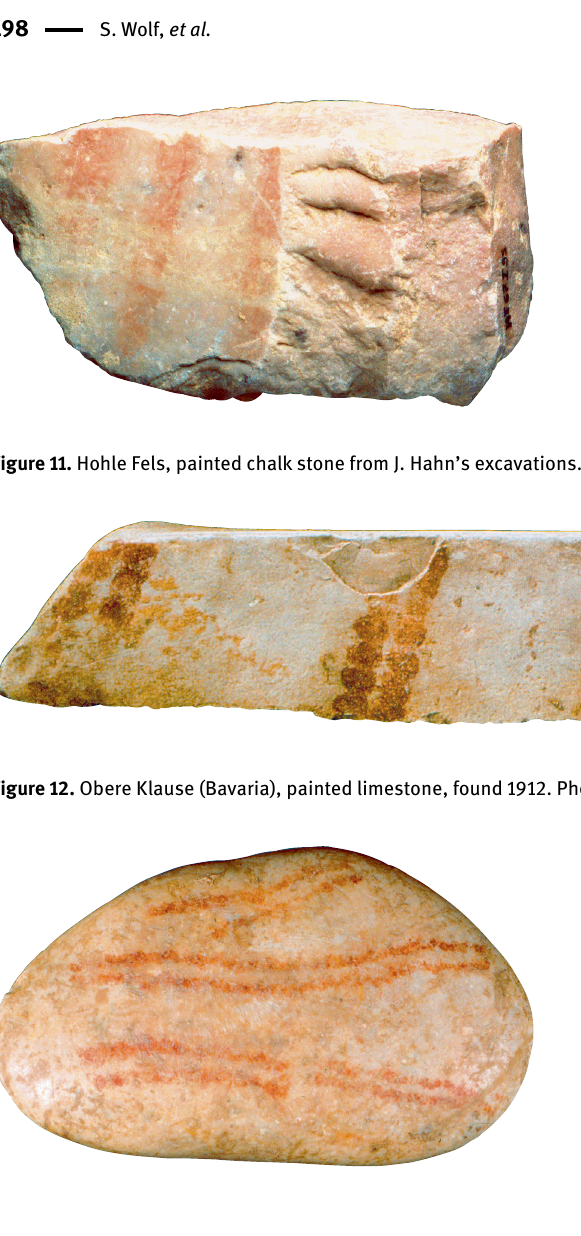
Figure 13. Kleine Scheuer (Lone Valley), painted pebble, found 1923. Photo: H. Jensen, Univ.